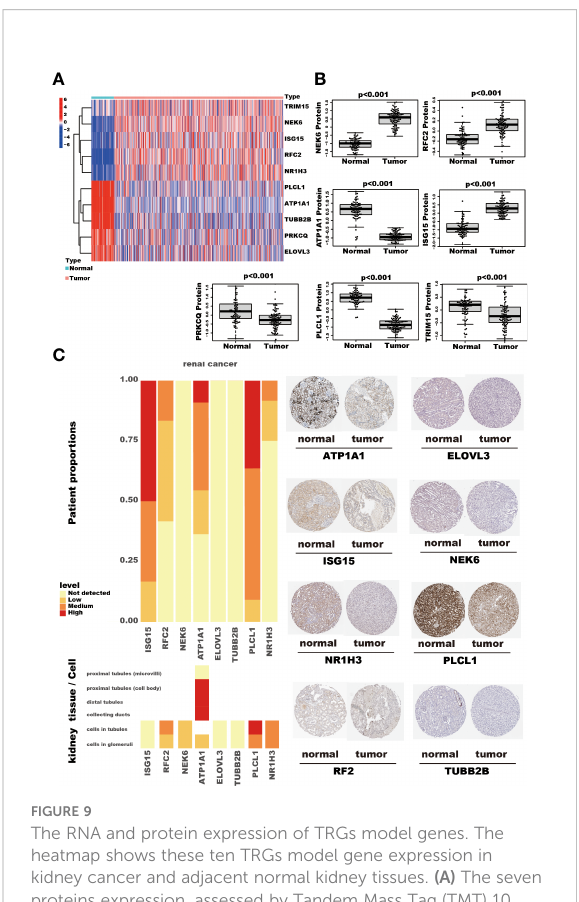
FIGURE 9 The RNA and protein expression of TRGs model genes. The heatmap shows these ten TRGs model gene expression in kidney cancer and adjacent normal kidney tissues. (A) The seven proteins expression, assessed by Tandem Mass Tag (TMT) 10 method, compares the kidney cancer and adjacent normal kidney tissues in the CPTAC cohort. The thin lines represent the maximum and minimum values, and the thick line represents the median value. (B) The detection of eight proteins by IHC in the HPA database. (C) .